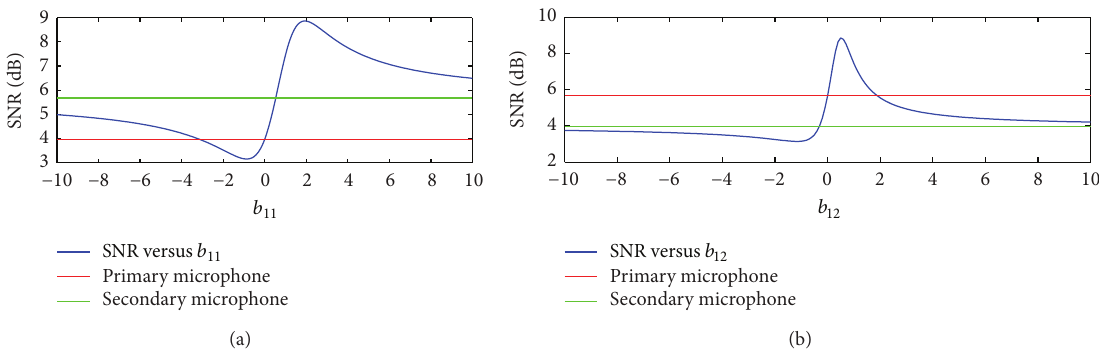
Figure 4: Plot of SNR as the unmixing matrix coefficient 𝑏 12 is varied, for the two channels shown in Figure 3. The first (a) fixes the primary microphone as constant and adds the secondary microphone scaled by 𝑏 12 . The second (b) fixes the secondary microphone as constant and adds the primary microphone scaled by 𝑏 12 . Both yield approximately the same peak.